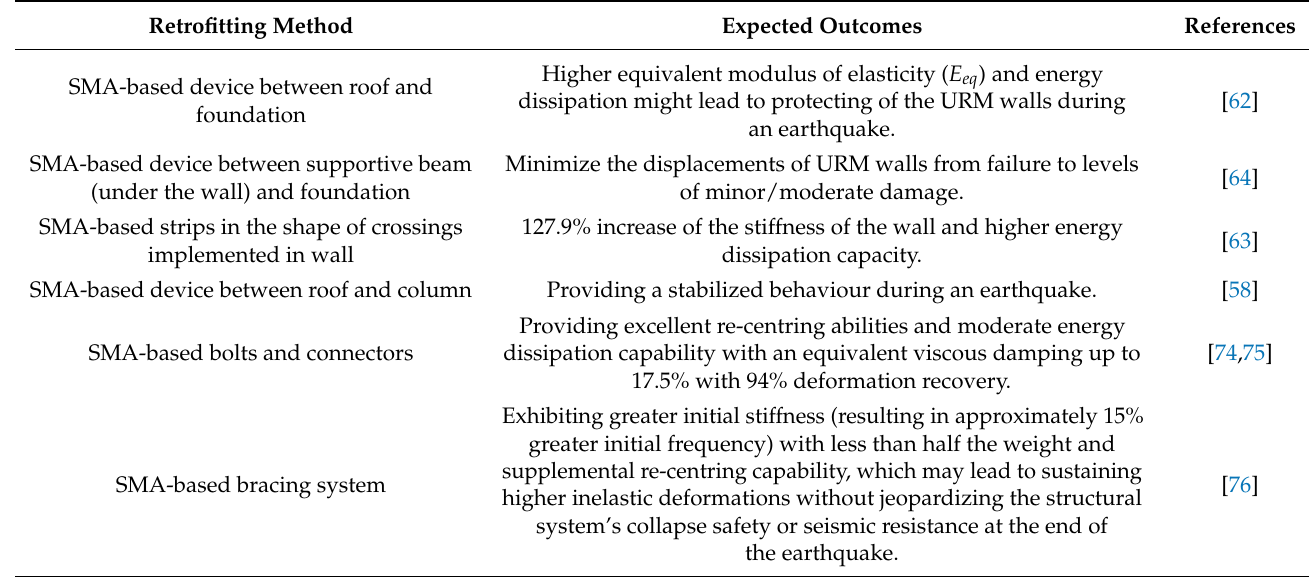
Table 5. The retrofitting methods and their expected outcome of the proposed